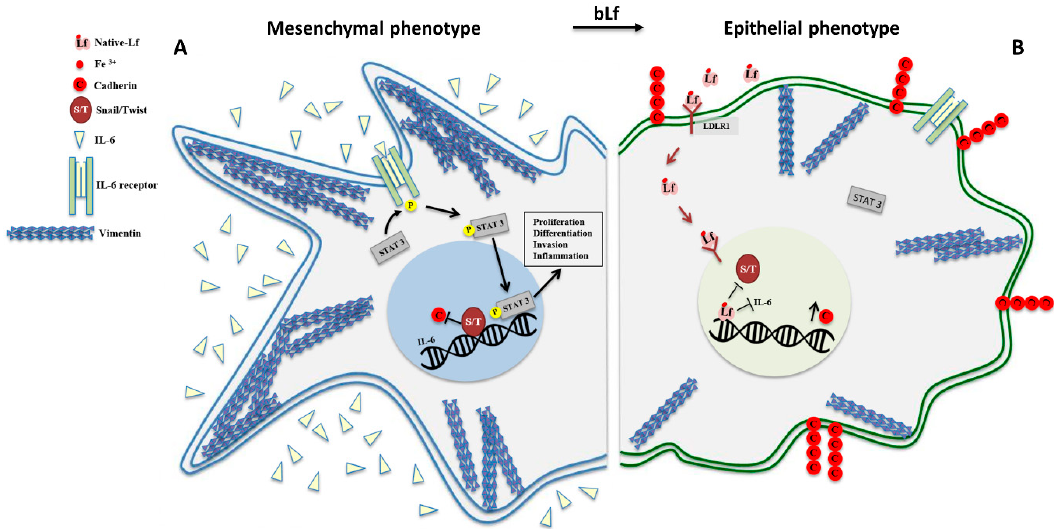
Figure 2. Schematic representation of bovine Lactoferrin (bLf) efficiency in counteracting migration and invasion by reverting epithelial-to-mesenchymal transition (EMT) process in cancer cells. ( A ) Mesenchymal phenotype, characterized by a spindle-like shape, presents high levels of vimentin and Snail / Twist (S / T), down-regulation of cadherins’ expression and p-STAT3-activation by interleukin (IL)-6. All these factors let the cell to acquire an invasive phenotype able to detach from the primary site and invade surrounding tissues and blood vessels. ( B ) Epithelial phenotype upon bLf treatment, which is able to revert EMT by its multi-targeting activity. After LRP1-mediated uptake and nuclear localization, bLf down-regulates vimentin, Snail and Twist expression, thus increasing cadherins’ levels. Moreover, bLf inhibits IL ‐ 6 ‐ mediated STAT3 activation.